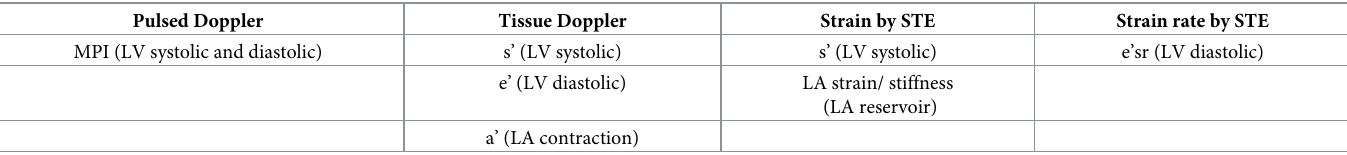
Table 1. Variables used to assess subclinical myocardial function. Pulsed Doppler Tissue Doppler Strain by STE Strain rate by